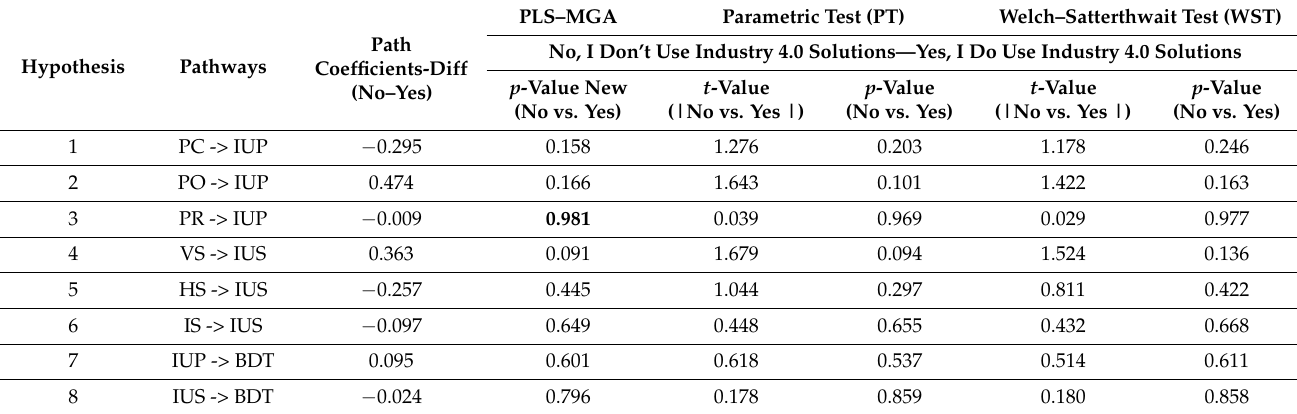
Table 7. Differences between groups “No, I don’t use Industry 4.0 solutions” and “Yes, I do use Industry 4.0 solutions”.